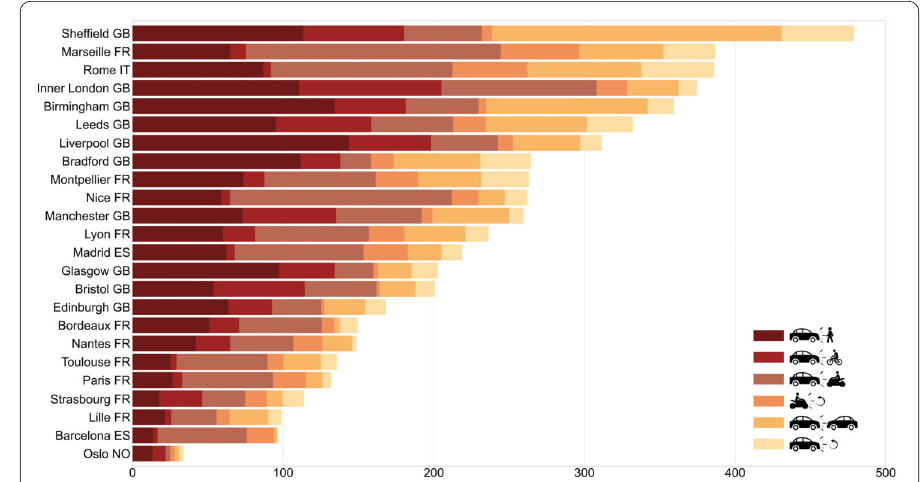
Figure 3 Killed or seriously injured (KSI) individuals per 1 million inhabitants are heterogeneous between different cities and road participant pairs. The figure reports very different levels of road safety in terms of killed or seriously injured (KSI) individuals per 1 million inhabitants in 2018. Sheffield (GB) leads with almost 500 KSI, whereas Oslo (NO) has close to zero KSI. French cities mostly have lower KSI rates, in contrast to most of the British cities which show high KSI rates often double the amounts of French cities. The most vulnerable traffic participants, pedestrians and cyclists, are highlighted in maroon and red, respectively. Their KSI rates are highest in Inner London (GB), Liverpool (GB), and Birmingham